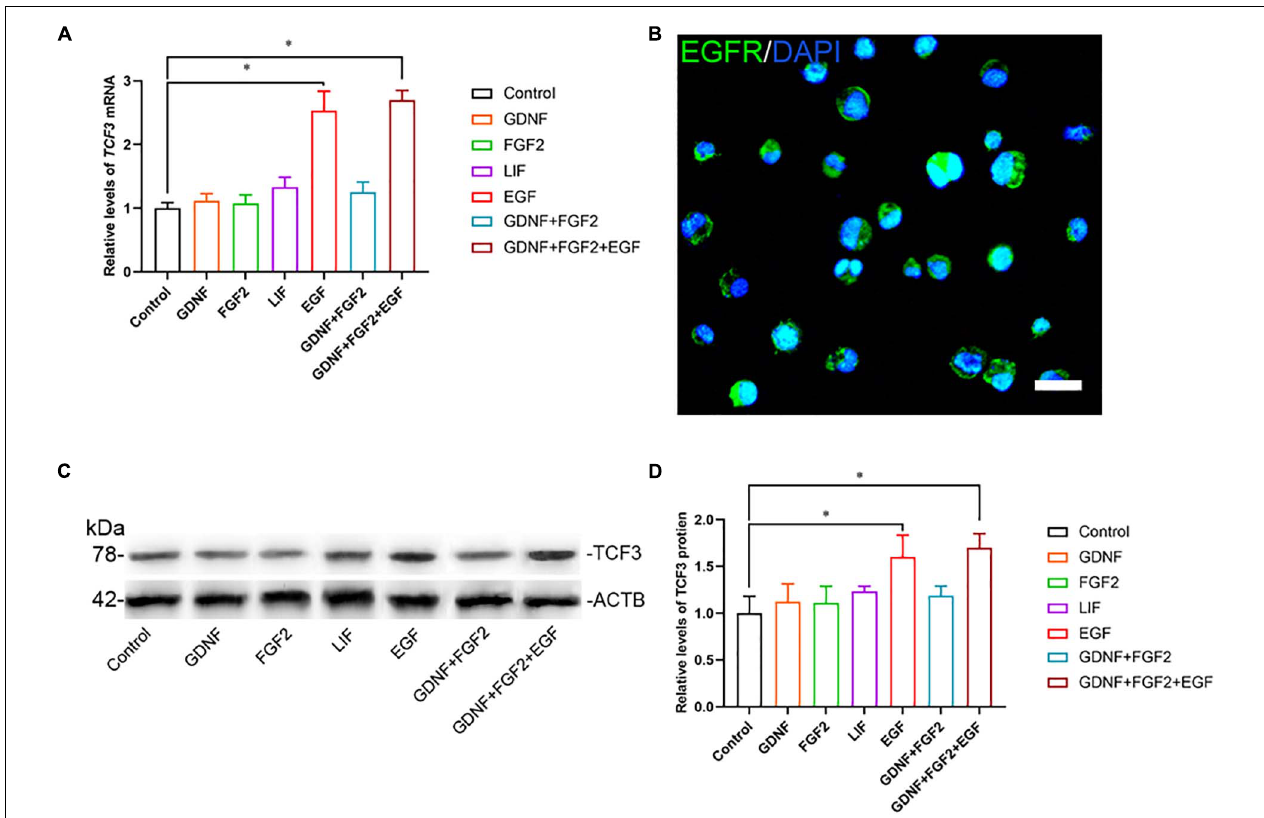
FIGURE 2 | The effect of growth factors GDNF, FGF2, LIF, and EGF on TCF3 expression. (A) qPCR assessment of mRNA levels of TCF3 by growth factors GDNF, FGF2, LIF, and EGF in human SSC line. (B) Immunofluorescence showed the presence of EGFR in human SSC line. (C,D) Western blotting displayed TCF3 levels by several growth factors. Scale bar: (B) , 20 µ m. ∗ p < 0.05 indicated the significant differences between the growth factor and the